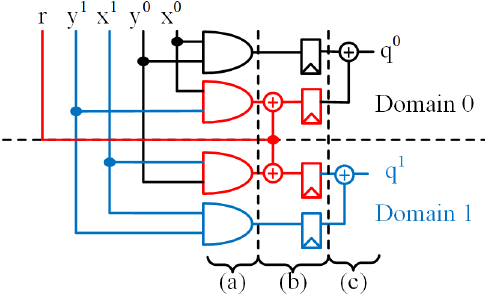
Figure 1: The design of a first-order pipelined DOM-indep multiplier [GMK16]. The components in black and blue belong to domains 0 and 1 respectively. The red colored components represent the cross-domain terms. (a), (b), and (c) refer to the calculation , resharing , and compression steps,